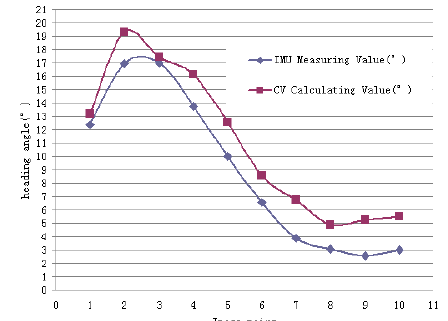
Figure4.The comparison of heading value from IMU and